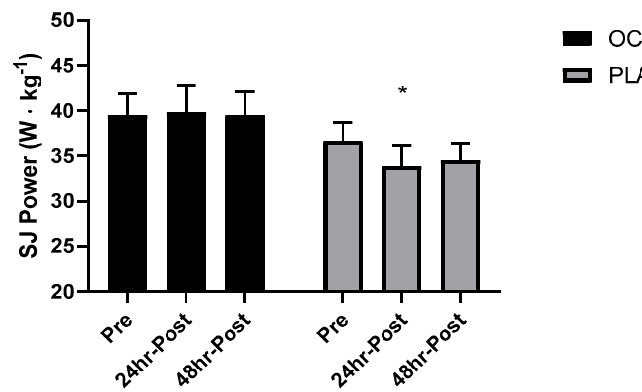
Figure 3. Bar charts displaying the mean and standard error for the relative power output during the squat jump (SJ) in the Oceanix (OCX) and placebo (PLA) conditions collected prior to the supplement period (Pre), one day, and two days following the supervised cross-training bout (24 h Post and 48 h Post, respectively). * = significantly lower than OCX ( p < 0.05).